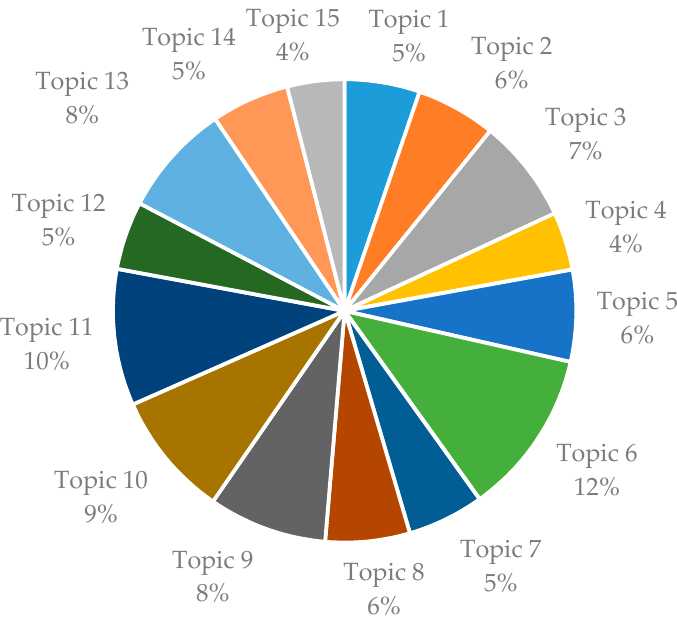
Figure 4. Ratio by Figure 4. Ratio by topic